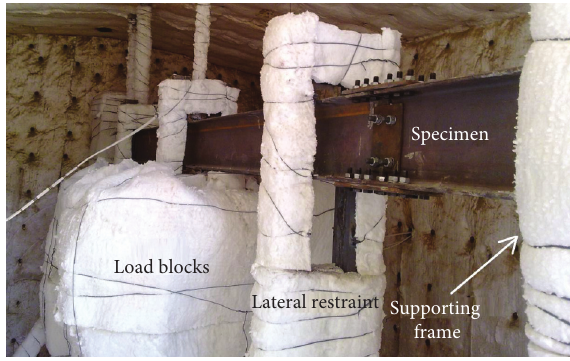
Figure 9: The load blocks in fire tests